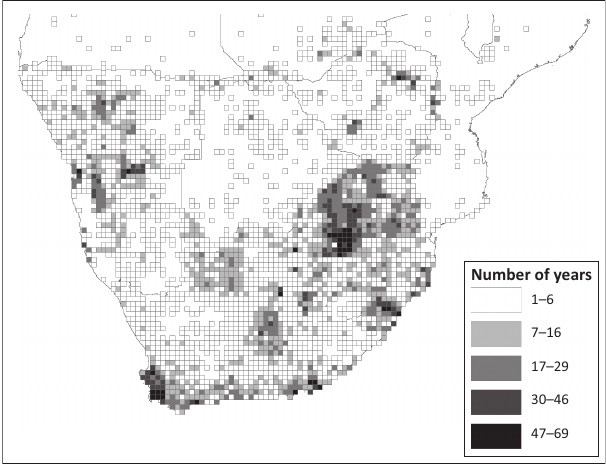
FIGURE 1: Distribution of ringing effort across southern Africa. The quarter degree cells are shaded according to the number of calendar years that ringers were active between 1948 and 2017.